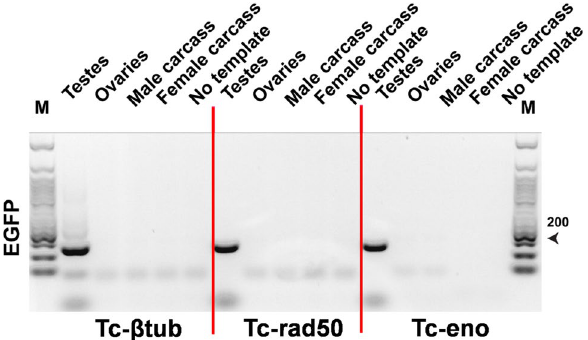
Figure 7. Transcription of the EGFP reporter in transgenic strains is testes-specific. cDNA from Tc-β 2 t- EGFP#2, Tc-Rad50-EGFP#1 and Tc-Eno-EGFP#1 transgenic lines was used to perform the RT-PCR. T. castaneum RpSL32 served as a control for cDNA quality (same samples as shown in Fig. 1). Lane#M is 50 bp DNA Ladder Catalog No. (N3236S) New England Biolabs.